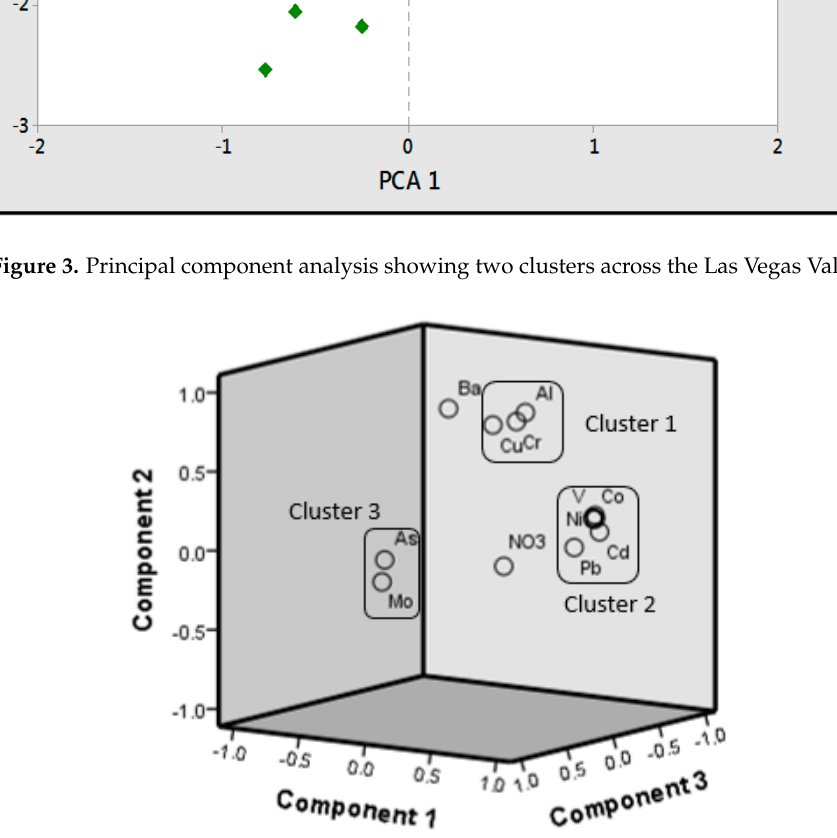
Figure 4. Component plot in rotated space explaining dataset from across the Las Vegas Valley.